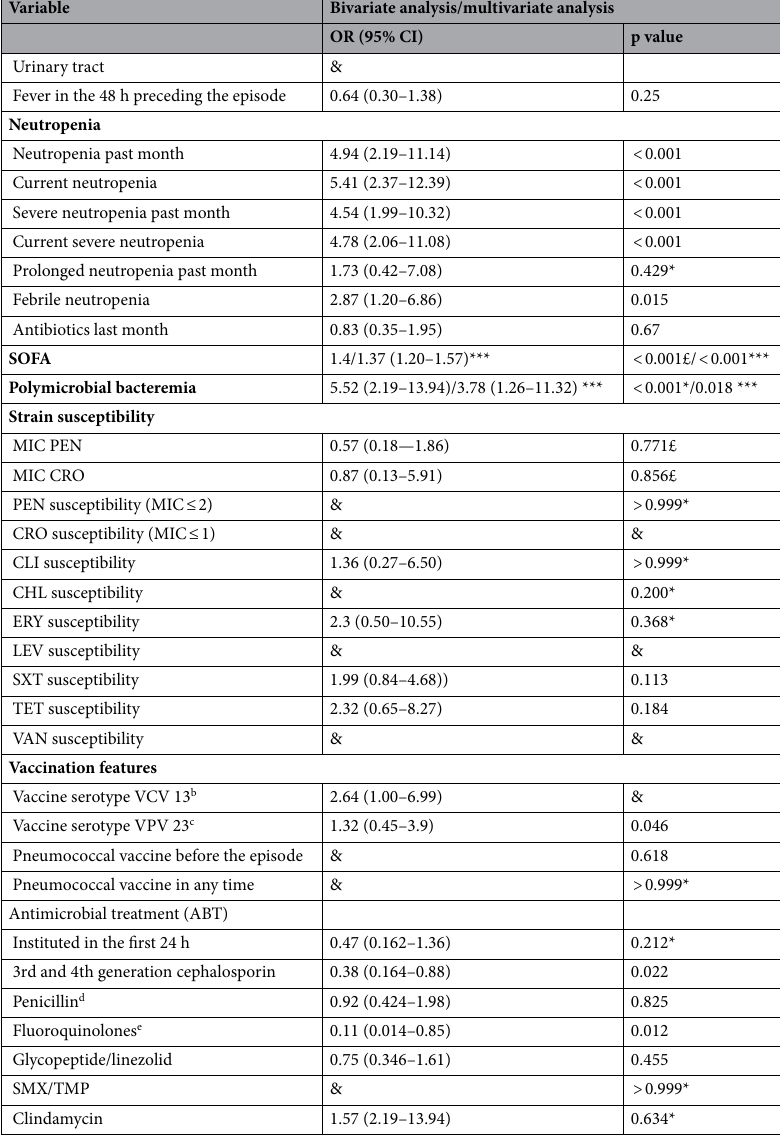
Table 3. Factors potentially associated with 48 h mortality according to characteristics evaluated and results of bivariate and multivariate tests in 161 episodes of bacteremia caused by Streptococcus pneumoniae in cancer patients. Chi-square test; *Fisher exact test; # Likelihood ratio test; **T-Student Test; £ Mann–Whitney test; & Cannot estimate; ***Multiple logistic regression. COPD chronic obstructive pulmonary disease, GTI gastrointestinal tract (esophagus, stomach, small intestine, colon, anus and rectum), SST skin and soft tissue, PEN peniciin, CRO ceftriaxone, CLO chloramphenicol, ERY erythromycin, CLI clindamycin, VAN vancomycin, LEV levofloxacin, SXT sulfamethoxazole- trimethoprim, TET tetracycline. a Head and neck, oral cavity, larynx and pharynx. b Vaccine VCV 13. or pneumococcal conjugate vaccine 13. c Vaccine VPV 23. or pneumococcal polysaccharide vaccine 23. d Oxacillin, amoxicillin, piperacillin-tazobactam. e Moxifloxacin, levofloxacin. MIC minimum inhibitory